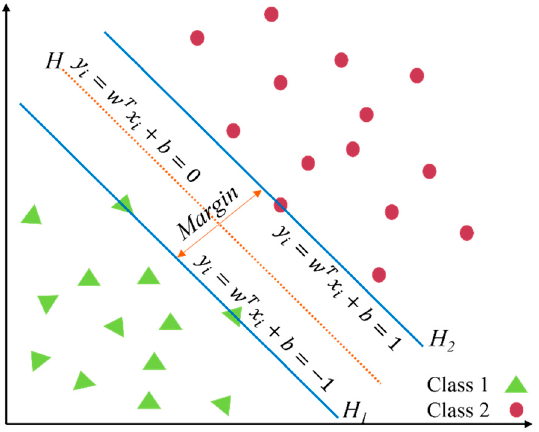
Figure 6. Optimal separation hyperplane.